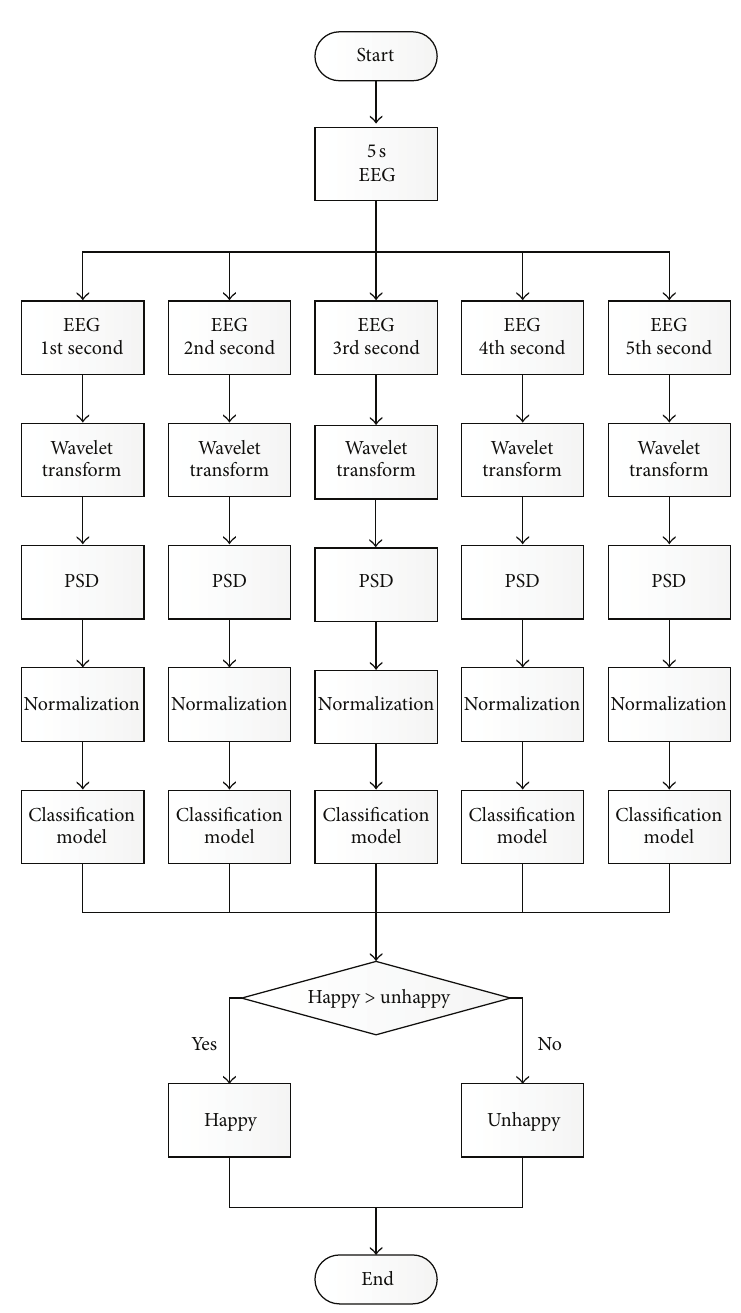
Figure 10: Flowchart of real-time happiness detection